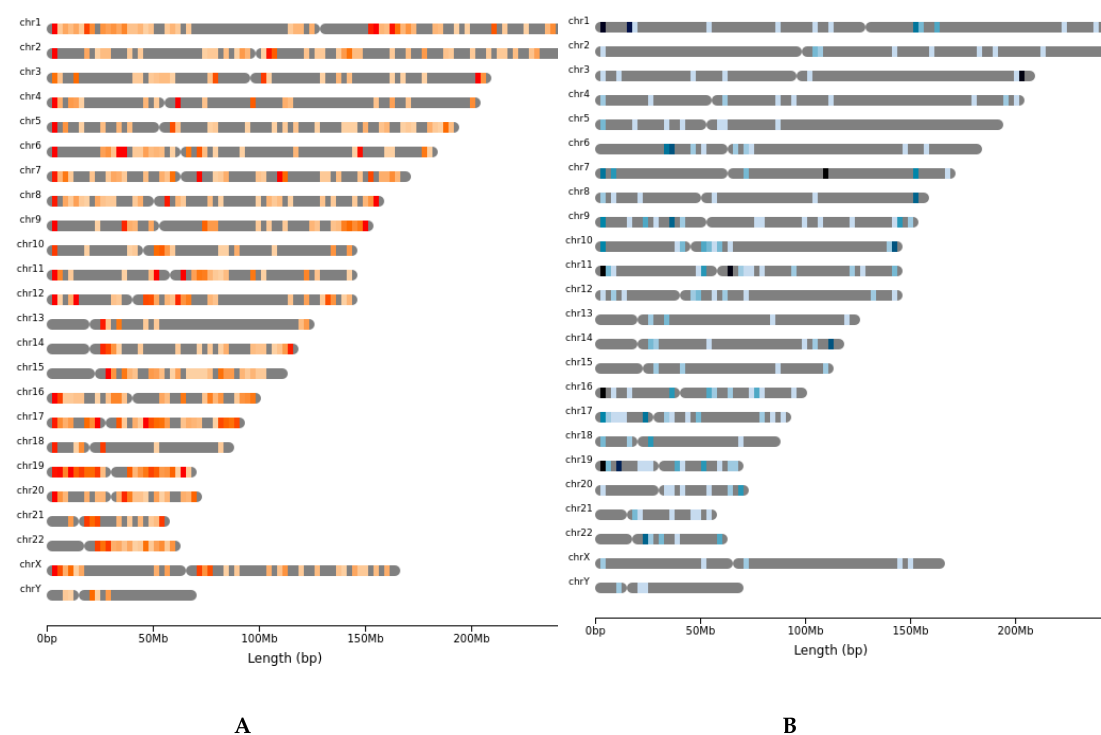
Figure 5. CNA from Sequenza, plotted using the chromoMap package, for the 27 rare cancer cases. ( A ) Heat map showing frequency of amplified regions along the chromosomes. ( B ) Heat map of deleted regions along the chromosomes.